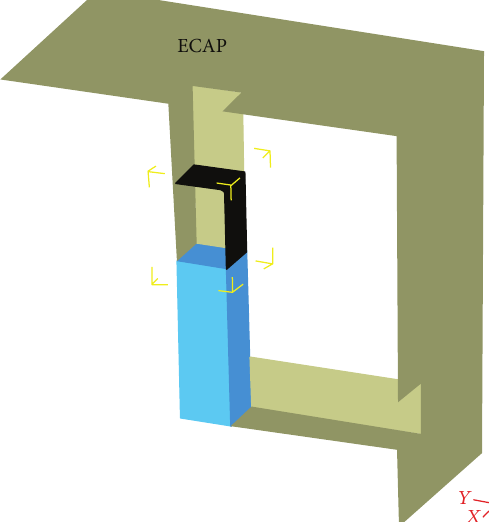
Figure 1: Workpieces geometry, punch, and ECAP die used in the